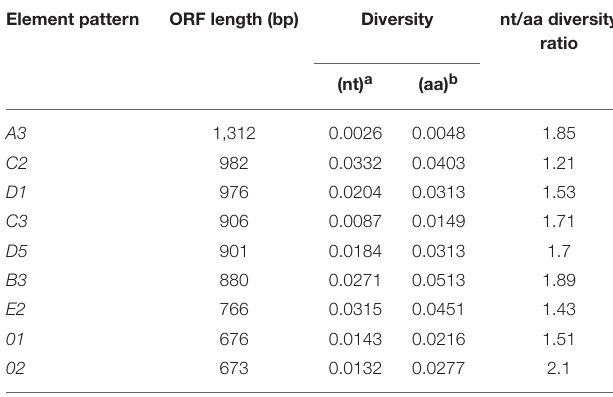
TABLE 1 | Sequence diversity ratios indicate diversifying selection for the SpTrf